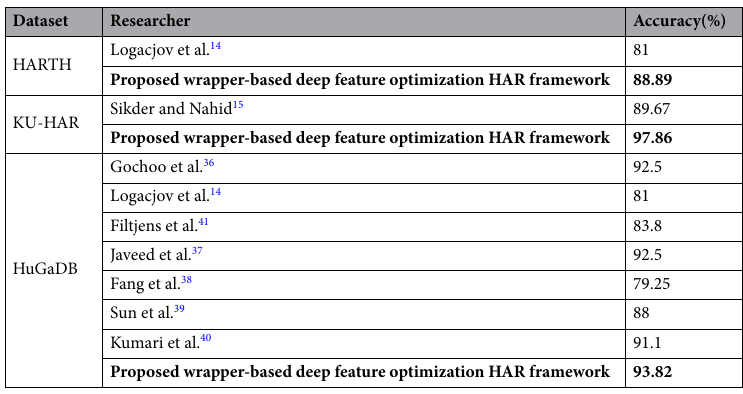
Table 8. Performance comparison (in terms of classification accuracies) of our proposed wrapper-based deep feature optimization method with some existing HAR works implemented on the HARTH, KU-HAR, and HuGaDB datasets. Bold indicates the least number of features selected and highest values of accuracy, Recall, Precision and F1-score attained for each of the HAR datasets.